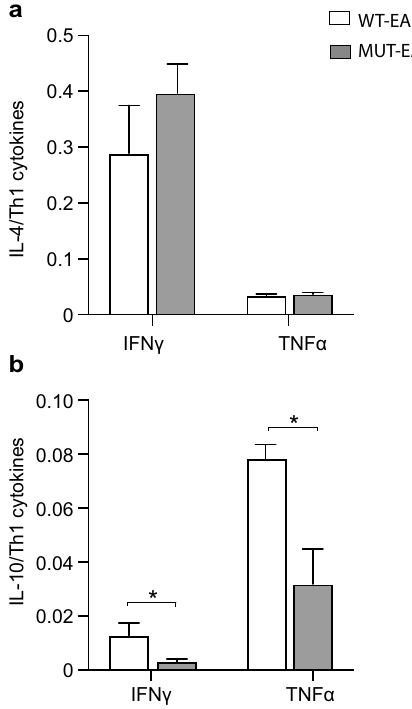
Figure 3. Th2/Th1 ratios during acute EAE. Comparative ratios were calculated between the production of anti-inflammatory cytokines (IL-4, IL-10) and the pro-inflammatory cytokines (IFNγ and TNFα) from WT-EAE and MUT-EAE isolated splenocytes re-stimulated in vitro with MOG. The ratios between ( a ) IL-4/ IFNγ and IL-4/ TNFα, ( b ) IL-10/IFNγ and IL-10/TNFα are displayed. The lower production of IL-10 from MUT-EAE + MOG splenocytes induced a decrease in the Th2/Th1 balance during the acute stage. All values are presented as media ± SEM. Mann–Whitney non-parametric test was performed. *p < 0.05. WT-EAE n = 4; MUT- EAE n = 5.